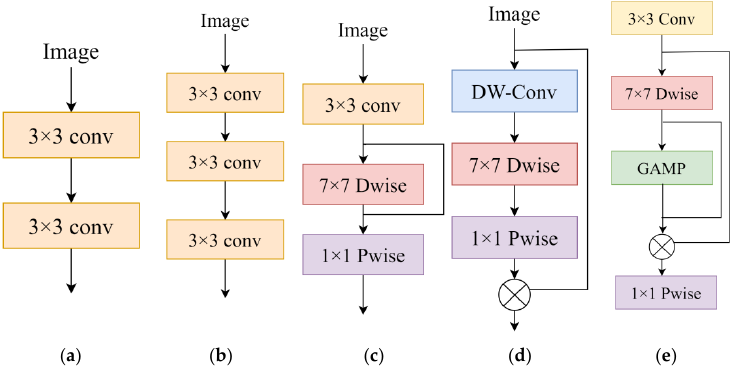
Figure 1. Comparing our DFA ( e ) with U-Net ( a ), Stem Block ( b ), LKA ( c ), and PFC ( d ) designs used to extract the low-level semantic information from the input images.